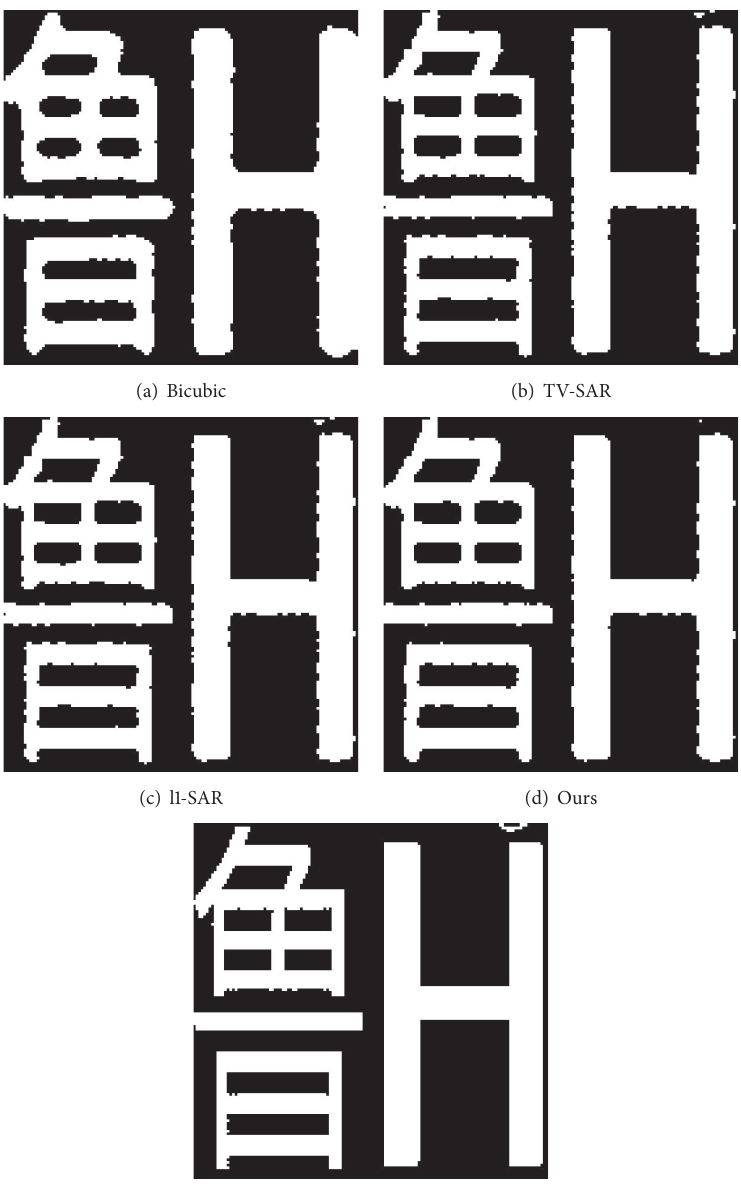
Figure 8: Binary results corresponding to Figure